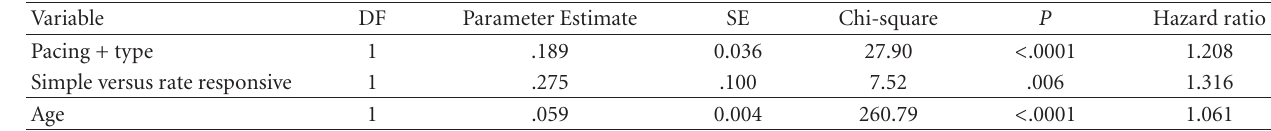
Table 7: Cox regression results using age, rate responsiveness, and 4-group pacing